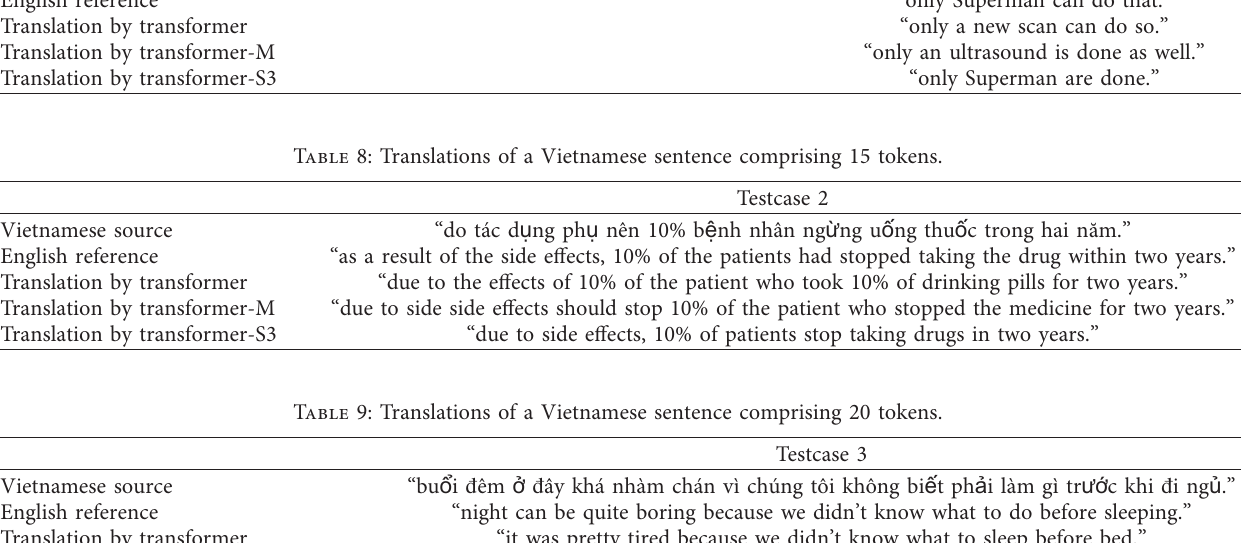
sentence. The subject “bang Gujarat” (meaning: the state of